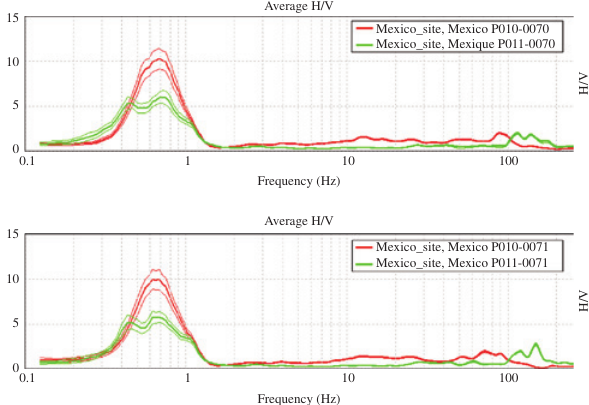
Figure 14: HVSR results. Measure 1 and 2 in same graph for sensor 70 (Top) and for sensor 71